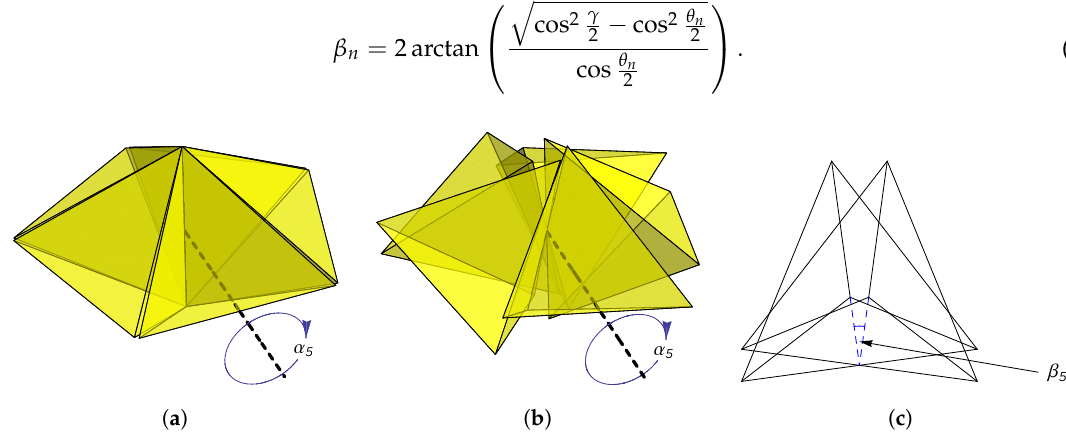
Figure 1. “Twisting” tetrahedra centered about a common central edge to close up gaps between adjacent tetrahedra. When this operation is performed, the angle β = arccos (( 3 φ − 1 ) /4 ) is produced in the projection of a “face junction”. ( a ) Five tetrahedra arranged about a common edge. In this arrangement, small gaps exist between the faces of adjacent tetrahedra. Each tetrahedron is to be rotated by α 5 about an axis passing between the midpoints of its central and peripheral edges. ( b ) The tetrahedra after rotation. In this arrangement, the faces of adjacent tetrahedra have been brought into contact with one another. ( c ) A projection of a “face junction” between two coincident faces in Figure 1b. The angular displacement between the faces is β 5 = β